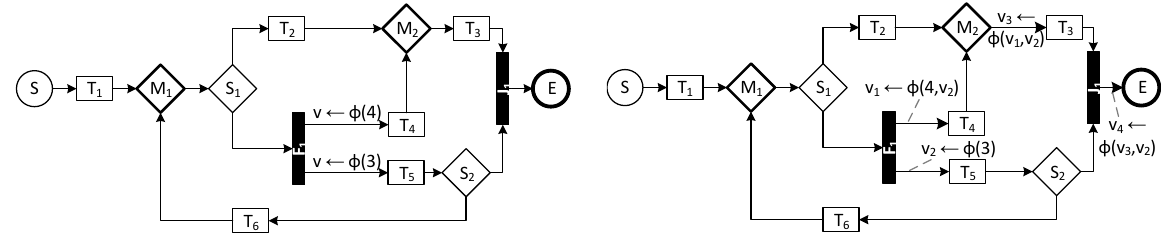
Figure 15. Two assignments of the fork -specific variable v (left workflow graph) and ϕ -placements for the fork -specific variable v (right workflow graph)